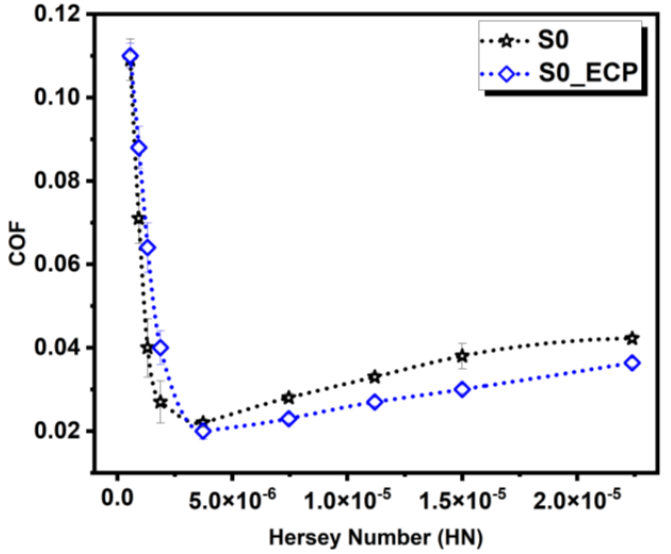
Figure 5. Stribeck curves of the specimens S0 and ECP_S C .